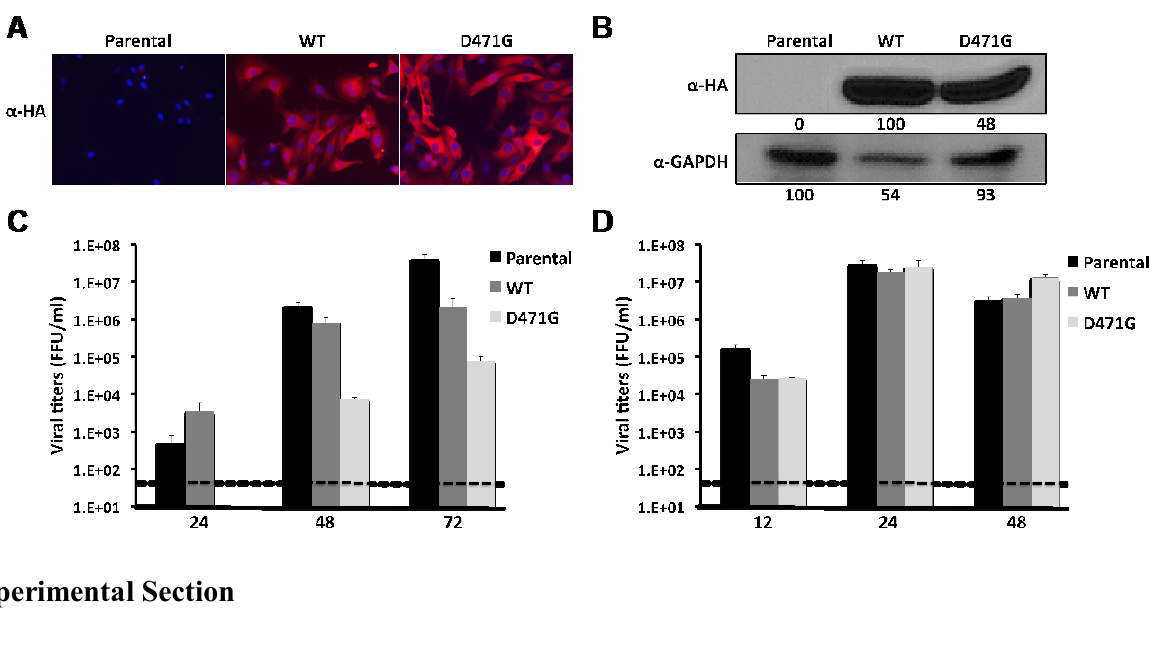
Figure 8. Dominant negative effect of NP D471G on LCMV infection. (A) Characterization of stable cell lines expressing HA-tagged wt mutant or D471G NPs. Parental and NP-HA expressing BHK-21 cell lines were examined by immunofluorescence with an anti- HA (α -HA) antibody (NP staining). Cellular nuclei were stained with DAPI. Representative merged images are illustrated. Cells lysates were prepared and 100 μg of total cellular protein content were analyzed by WB using an anti-HA antibody (B). GAPDH was used as a loading control. Numbers at the bottom of each WB lane represent the quantification of band intensities normalized to wt NP lane, as described in material and methods. Kinetics of LCMV (C) and VSV-GFP (D) propagation: Parental and NP-HA expressing BHK-21 cell lines were infected with LCMV (moi = 0.01) or VSV-GFP (moi = 0.001) in triplicates. TCS at the indicated hpi were titrated using a focus forming unit assay on Vero cells as described in materials and methods. Dashed lines indicate the limit of detection for the